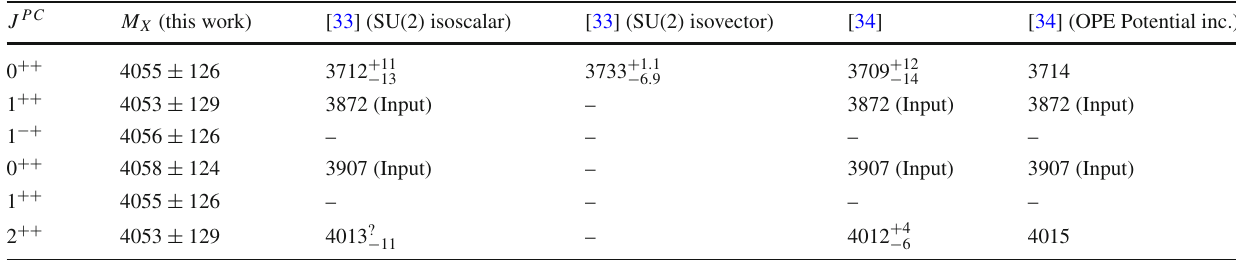
Table 3 X ( 3872 ) partners. All results are in